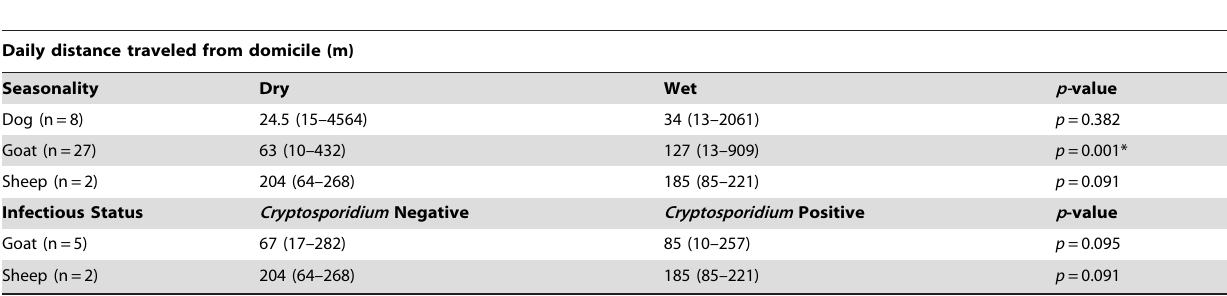
Table 1. Comparison of mobility patterns of domesticated animal species in Mwamgongo village adjacent to Gombe National Park, Tanzania.